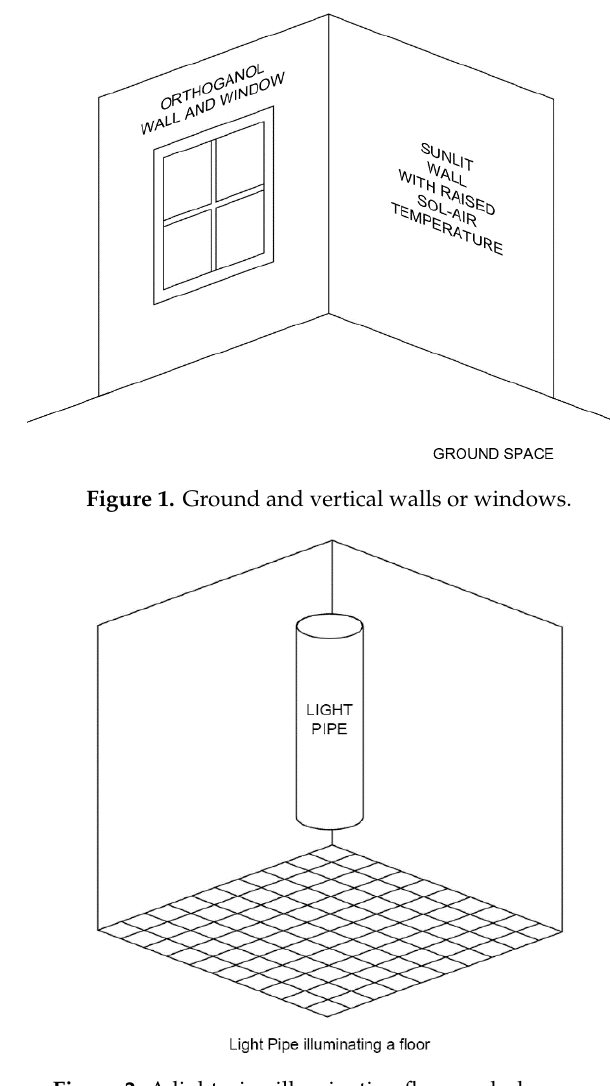
Figure 2. A light-pipe illuminating floor or desk spaces.